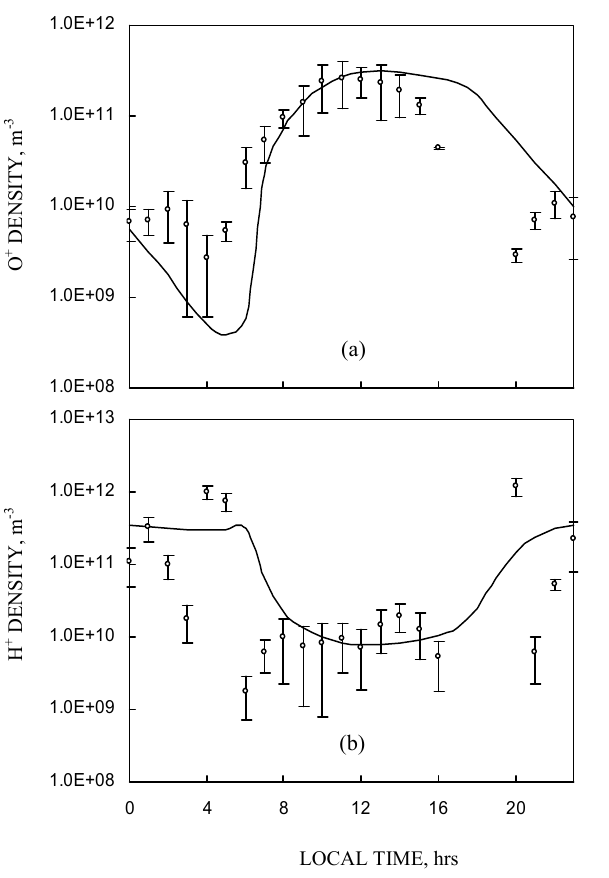
Fig. 7. Same as in Fig. 6 for 10 ◦ N geomagnetic